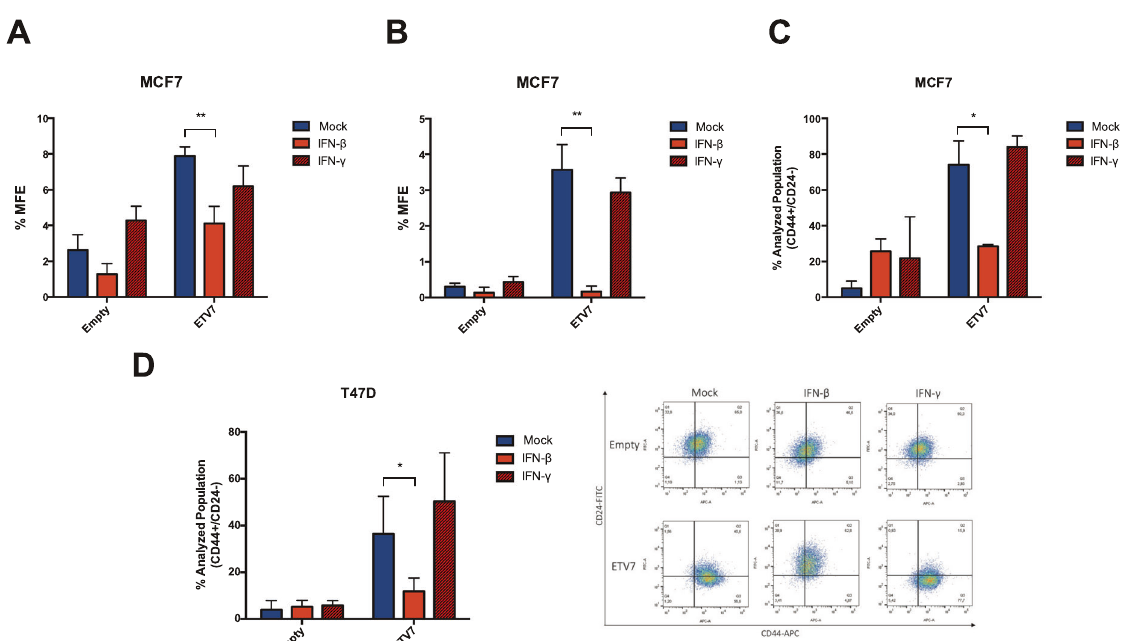
Fig. 5 IFN- β treatment reverses the breast cancer stem-like cell enrichment induced by ETV7. A , B Percentage of fi rst ( A) and second ( B ) generation mammosphere formation ef fi ciency (% MFE) in MCF7 Empty and ETV7 cells in response to 5 ng/ml IFN- β or IFN- γ calculated as number of mammospheres per well/number of cells seeded per well × 100. C , D Histograms summarizing the percentage of CD44 + /CD24 − cells measured by CD44-APC and CD24-FITC staining and fl ow cytometry analysis in MCF7 Empty and ETV7 cells ( C ) or T47D Empty and ETV7 cells ( D ) treated with 5 ng/ml IFN- β and IFN- γ for 2 weeks. A representative dot plot of the results obtained at FACS Canto A in T47D cells is shown on the right. Bars represent the averages and standard deviations of at least three biological replicates. * p -value < 0.05; ** p -value <